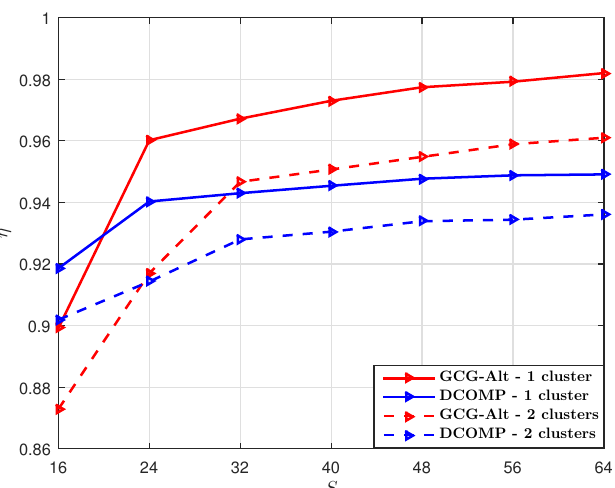
Figure 6. Comparison of η of the GCG-Alt estimator and the DCOMP estimator under the ULA system, where N t = 64, N r = 16,PNR = 10 dB, and T =